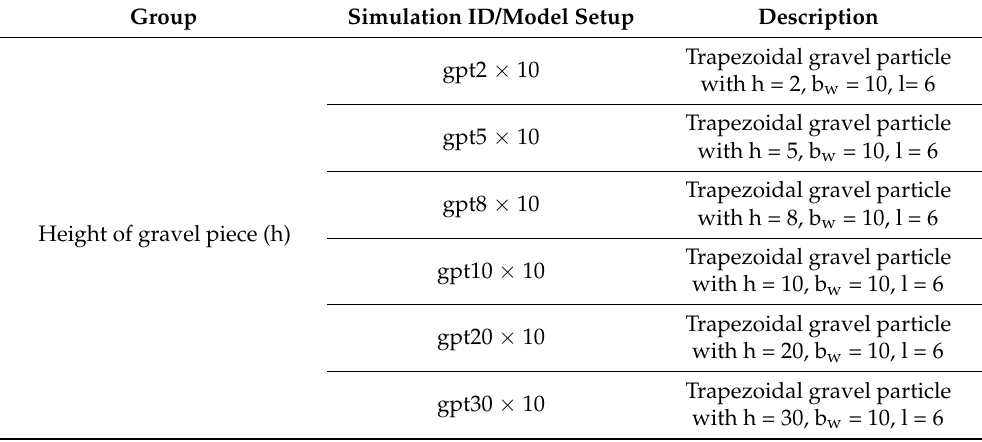
Table 1. Model setups for the analysis of the effect of height variation over hyporheic exchange. (h, b w and l denote the height, base width, and width of top surface of gravel pieces, respectively). Units are mm.